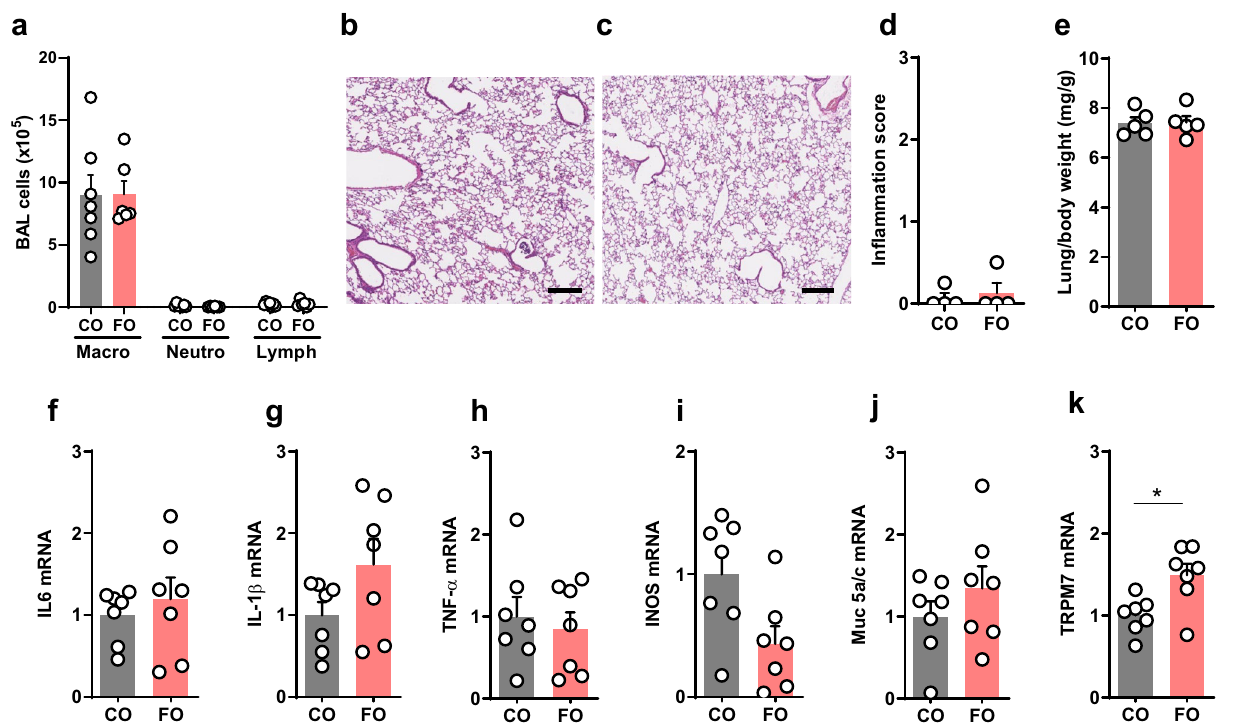
Figure 2. N-3 PUFA-enriched diet does not induce pulmonary inflammation. Analyses of lung and broncho- alveolar lavage fluid (BAL) from BALB/c mice that were fed a fish oil diet (FO) or an isocaloric control diet (CO) for 8 weeks. ( a ) Cytospin analysis of BAL cells. ( b , c ) Lung histology of CO ( b ) and FO ( c ) mice. Shown are representative lung sections stained with H&E, bar equals 250 μm. ( d ) Inflammatory score of histological sections. ( e ) Lung wet weights relative to body weight. ( f – k ) Expression of inflammatory markers in lung analyzed by Real-Time PCR: ( f ) IL-6. ( g ) IL-1β. ( h ) TNF-α ( i ) INOS. ( j ) Muc5AC; and ( k ) TRPM7. Data are means ± SEM of 5 animals per group. *p < 0.05. **p < 0.001, ***p < 0.0001. Shown are results of unpaired